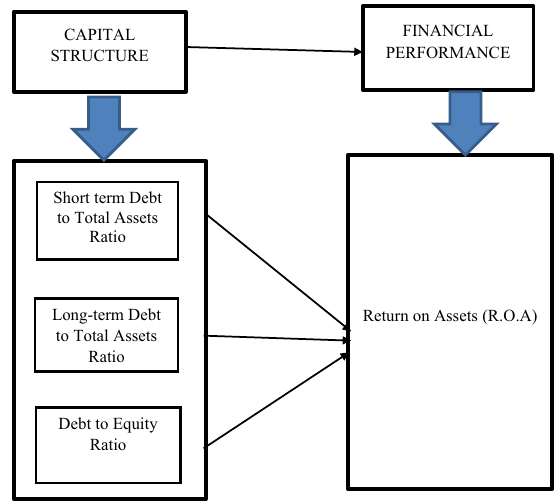
Fig. 1 Showing the link between capital structure and financial performance. Source : Author’s Framework